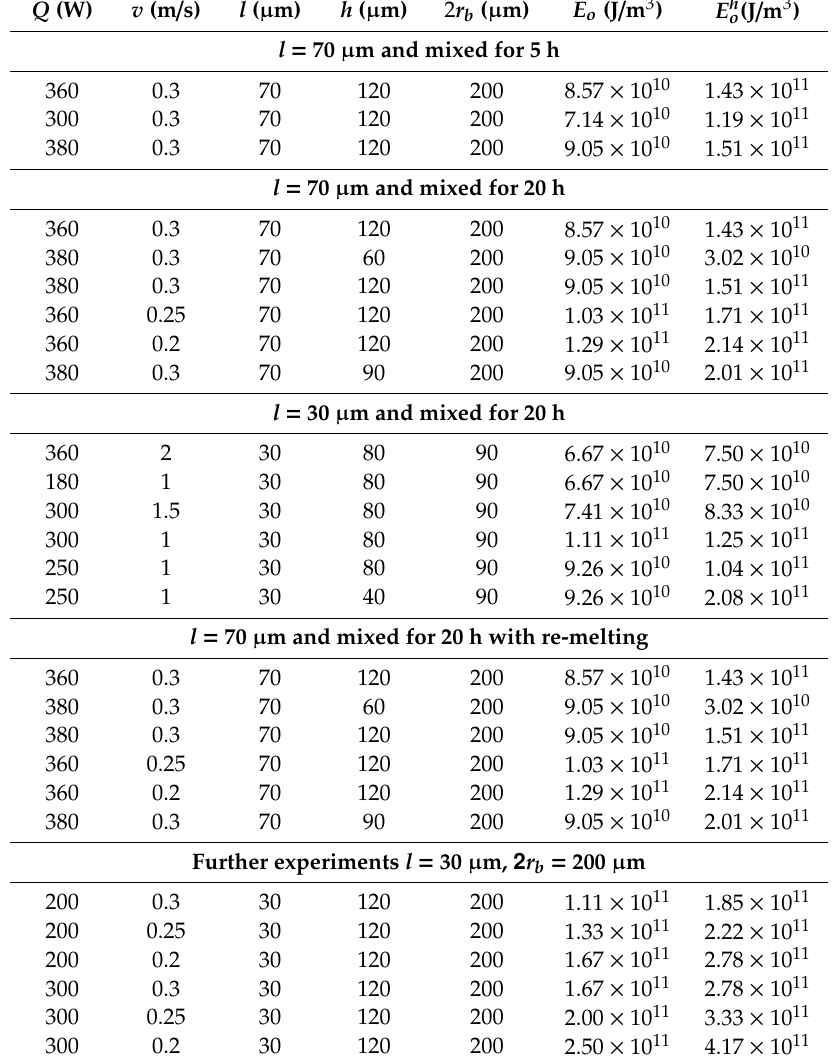
Di ff erent process parameters used for each sample are summarized in Table 1. The goal of the parameter selection was to scan over a broad range of laser powers, layer thickness, beam diameter, and scan speeds while keeping the energy density (nearly) constant. In this case we did not perform a full factorial DOE. Table 1. Process parameters and relative densities for AISI 304 L steel by in-situ alloying during laser powder bed fusion (LPBF) processing. Here Q , v , l , h , and r b are defined as laser power, laser scan velocity, layer thickness, hatch spacing, and laser beam radius, respectively. E o and E h o are volumetric energy densities defined as per Equation (1) and Equation (2),